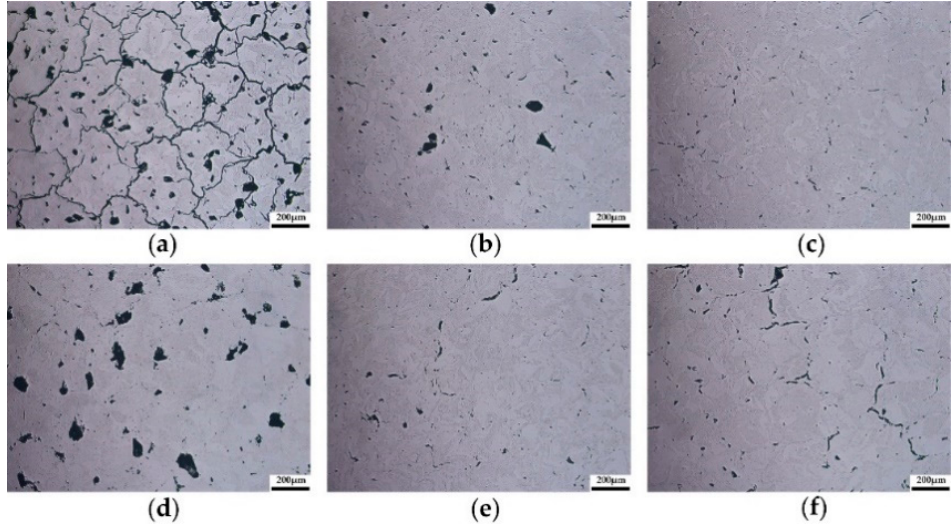
Figure 8. Cross-sectional morphology of different process parameters. ( a ) T8, ( b ) T17, ( c ) T26, ( d ) T1, ( e ) T20, ( f ) T27.